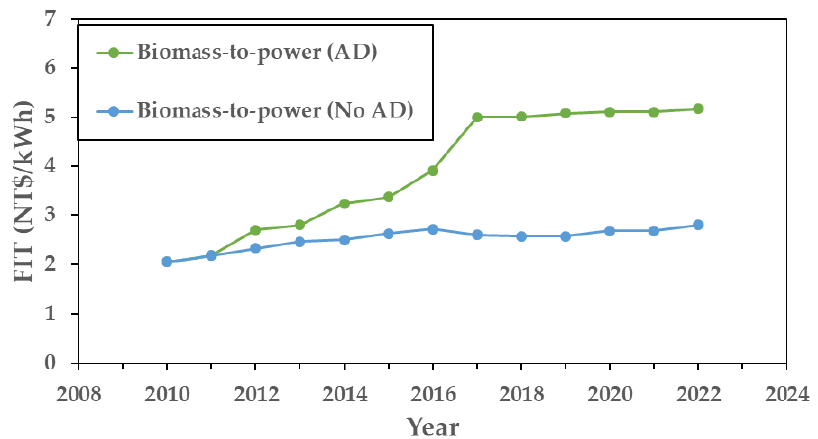
Figure 3. Variations in feed-in-tariff (FIT) rates for biomass-to-power and waste-to-power since 2010 [28].